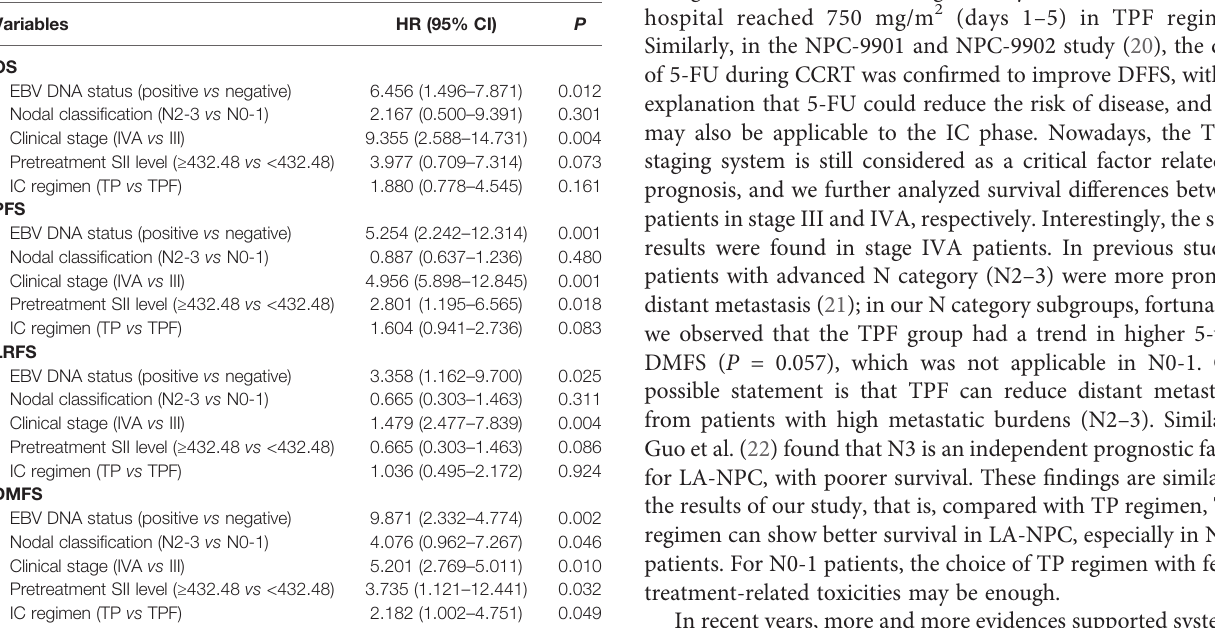
TABLE 3 | Multivariate cox regression analysis of prognostic factors for LA-NPC